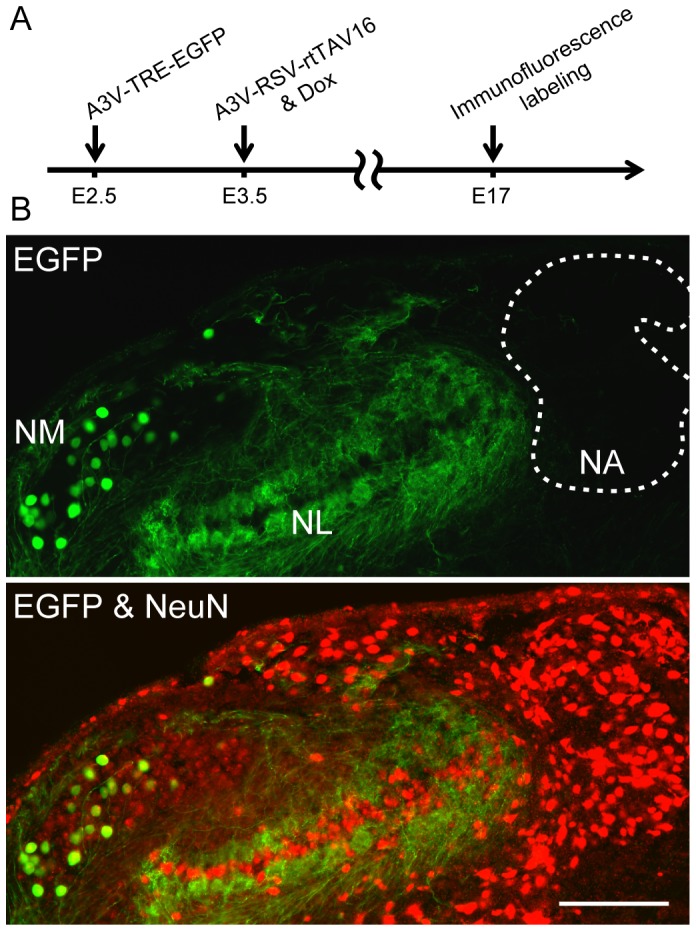
NM-selective transduction in the ITD-detection circuit.(A) Single doses of A3V-TRE-EGFP and A3V-RSV-rtTAV16 (0.5–1.5 µl, 1×1013 GC/ml each) were injected at E2.5 and at E3.5, respectively, and Dox was administered at E3.5. (B) Double immunofluorescence labeling for EGFP (green) and NeuN (red) was performed on coronal sections at E17. EGFP signal was observed in NM, but not in NL or NA. NA is outlined by the dotted line. Scale bar indicates 200 µm.